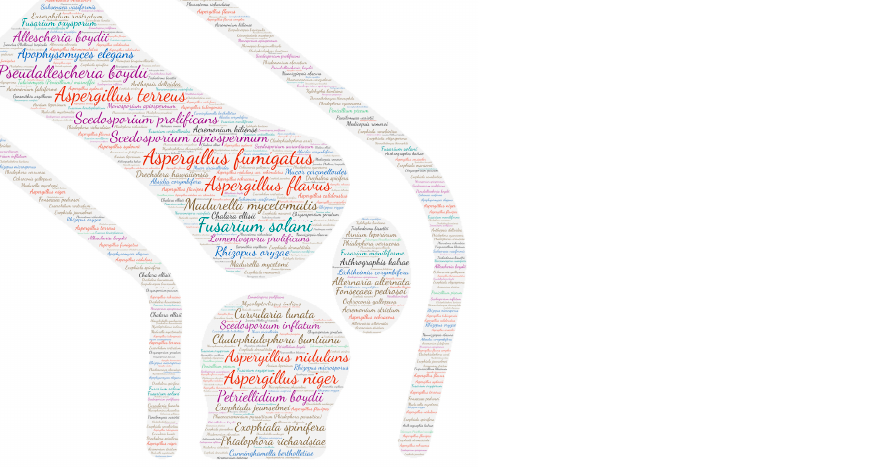
Figure 12. Wordcloud represents the species name isolated in the osteo-articular system. The size of the name of each species is proportional to the number of times it occurs in the repertoire.